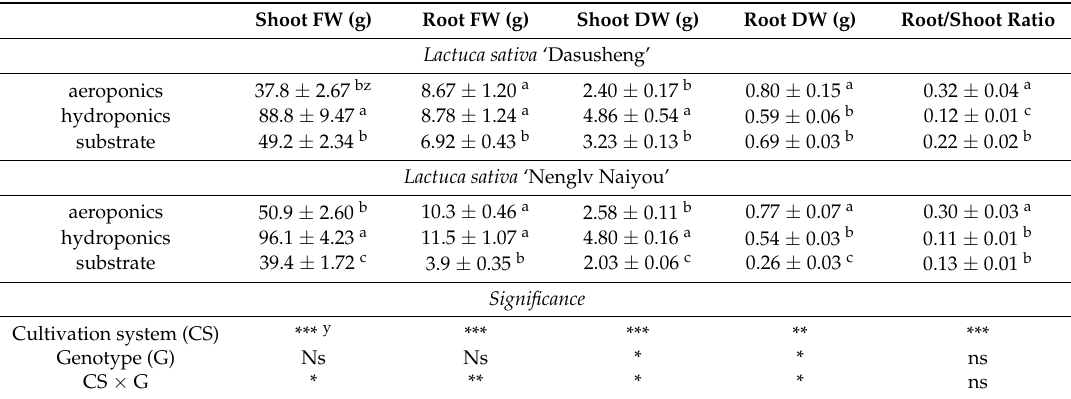
Table 1. Shoot and root fresh weight (FW), dry weight (DW), and root to shoot ratio of two lettuce cultivars grown in three cultivation systems.